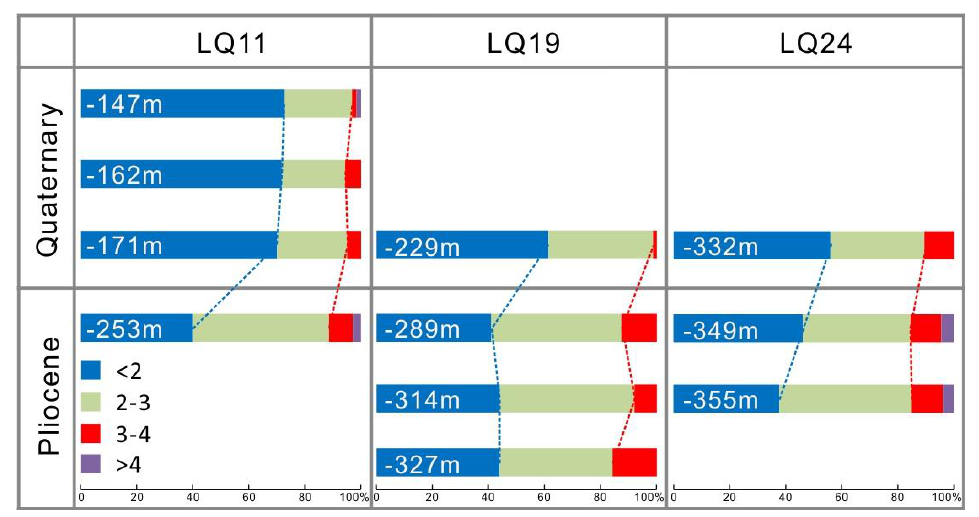
Figure 3. Features of detrital zircon elongation in the core sediment of LQ11, LQ19, and LQ24 in the Yangtze Delta.